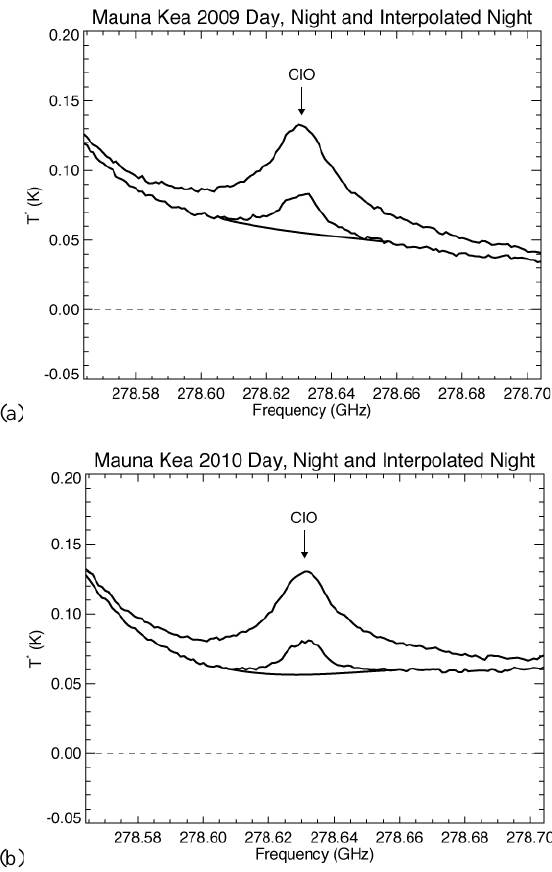
Fig. 2. Daytime, nighttime, and “interpolated nighttime” average spectra in 2009 (a) and 2010 (b)